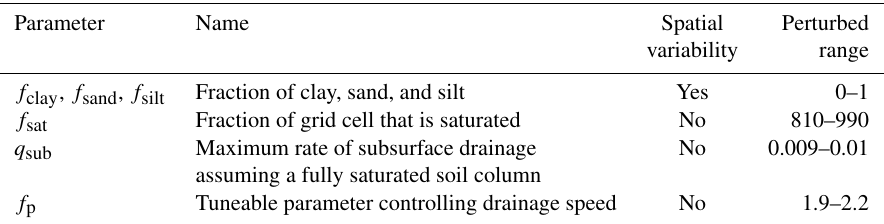
Table 2. Model parameters that are sensitive to SM and GWS estimates. The following parameters were perturbed using the additive noise with the boundary conditions given in the last column. The further parameter description can be found in Decker (2015) and Ukkola et al.